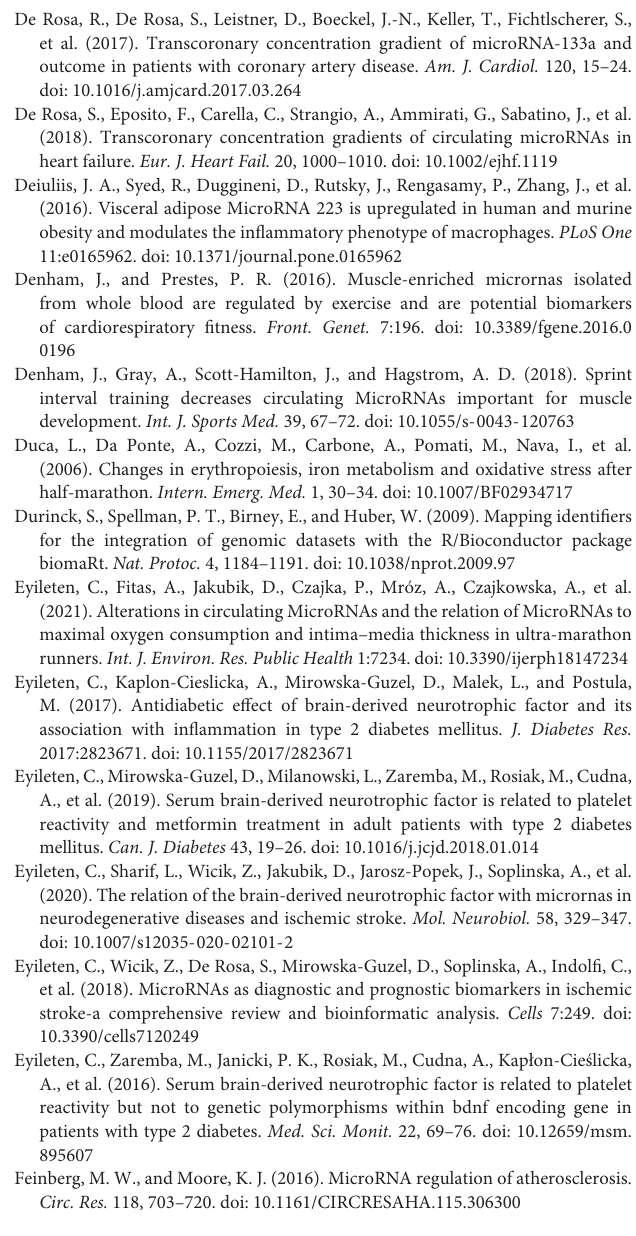
Supplementary Figure 1 | Enrichment analysis results of the selected miRNAs based on bioinformatic